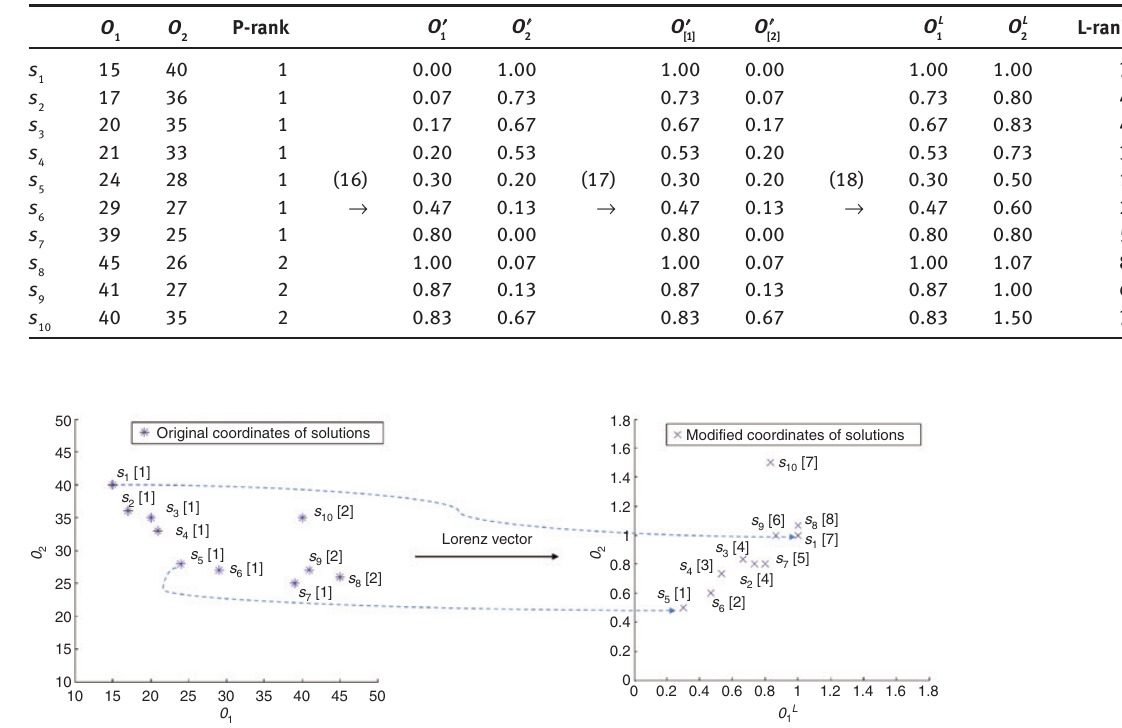
Table 3: A Numerical Example for the Lorenz Dominance.